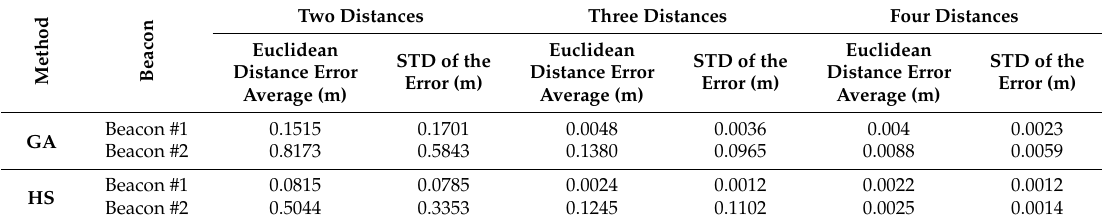
Table 4. Results according to the number of distances used for estimating the position of the beacon.